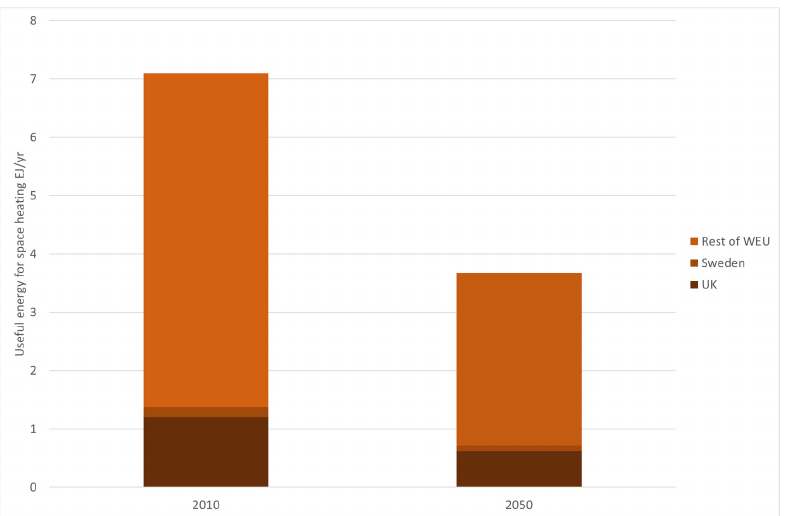
Figure A2. Downscaling of useful energy for heat. Total for Western Europe (WEU) derived from ‘1.5C Total’ scenario [16]. Linear scaling from 2010 calibration data applied in 2050.